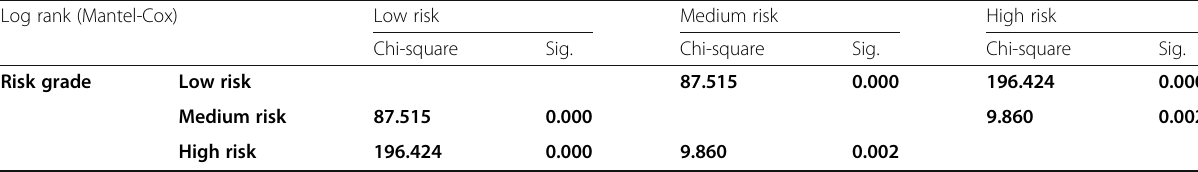
Table 6 Pairwise comparisons between hazard function of different risk grades Log rank